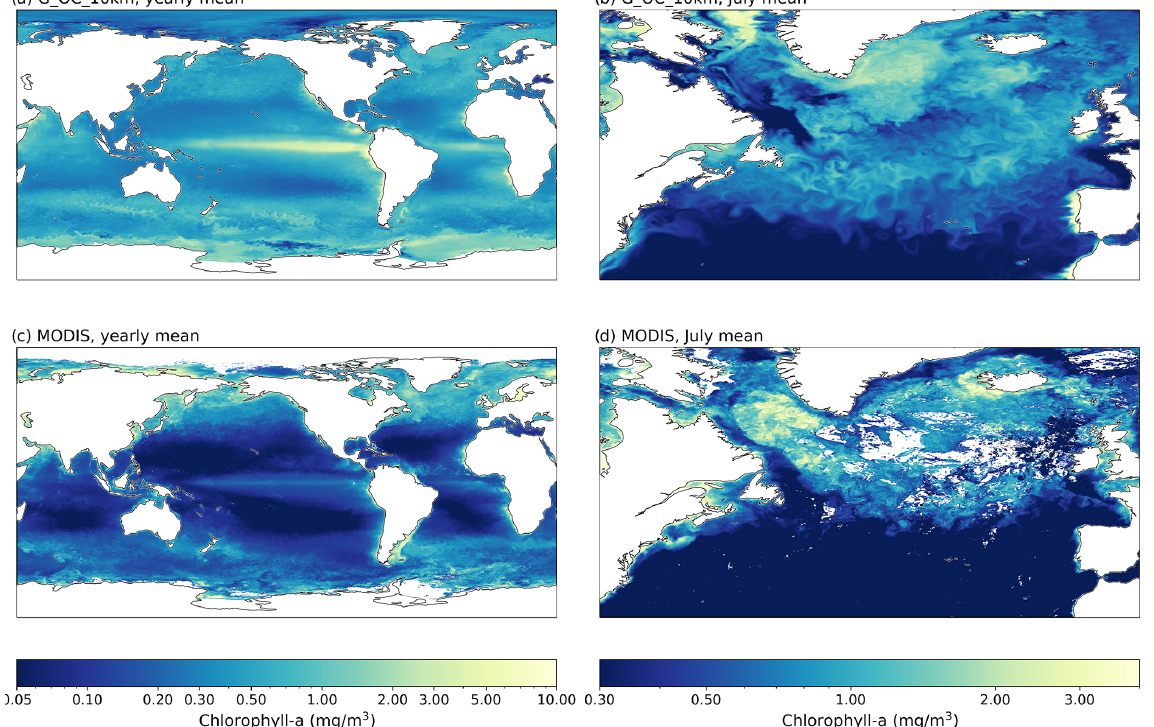
Figure 18. Chlorophyll a from (a, b) G_OC_10km and (c, d) MODIS observations (grid spacing of 4km) depicting (a, c) its global yearly mean distribution and (b, d) a zoomed-in view of the North Atlantic for July